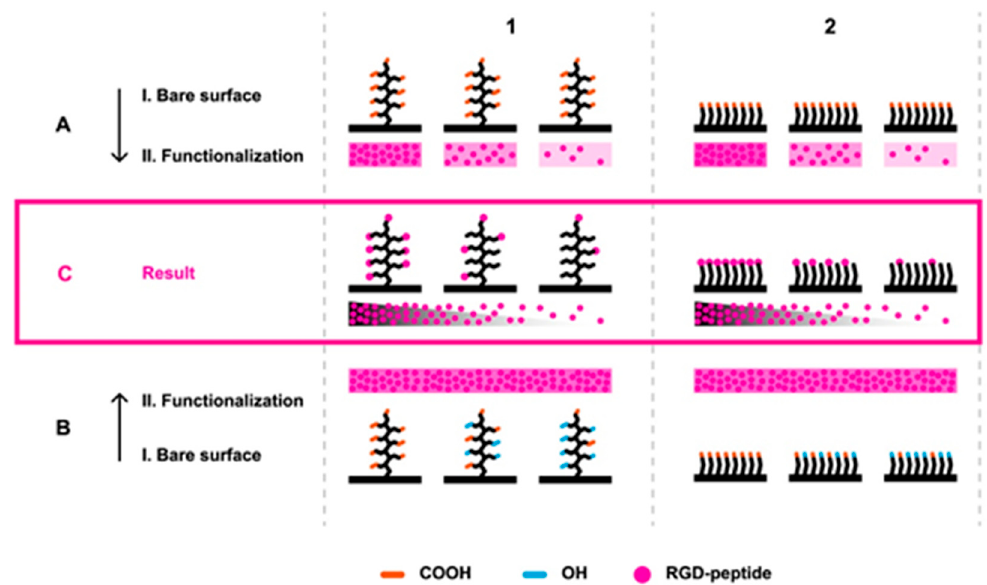
Figure 1. Immobilization strategies. Arginine, glycine, and aspartic acid (RGD)-functionalized sets of poly(carboxybetain) (pCB) coatings ( C1 ) and oligo(ethylene glycol) self-assembled monolayer (OEG SAM) coatings ( C2 ) were prepared using two di ff erent approaches. First ( A ), only carboxy-functional coatings were activated and exposed to solutions of RGD peptides with di ff erent concentrations.